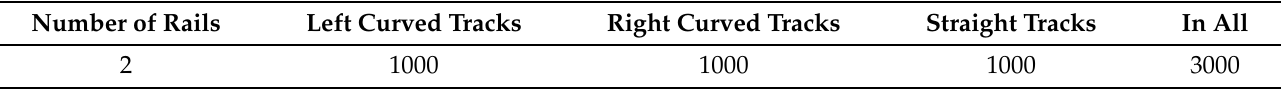
Table 2. Specific distribution of the